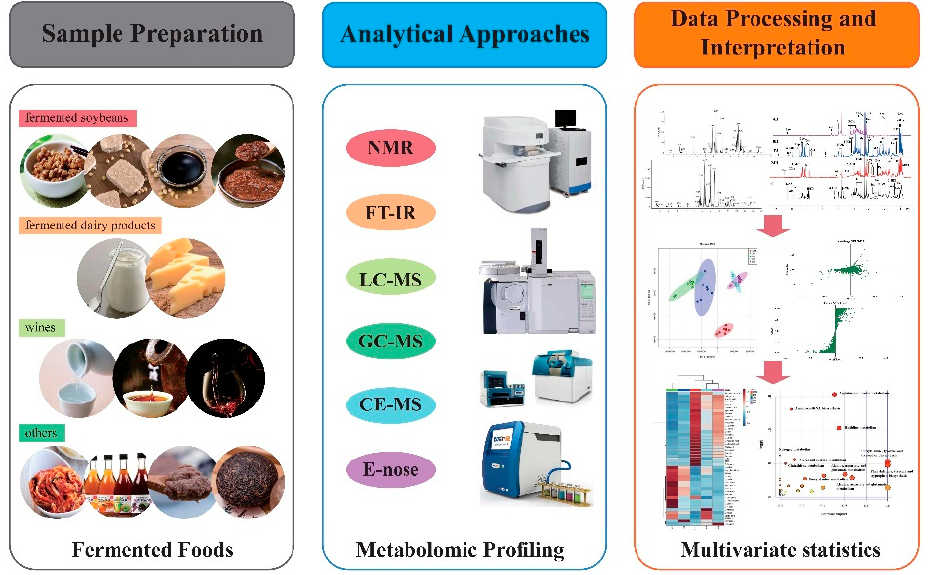
Figure 1. Schematic overview of the most important platforms used for metabolomics studies.